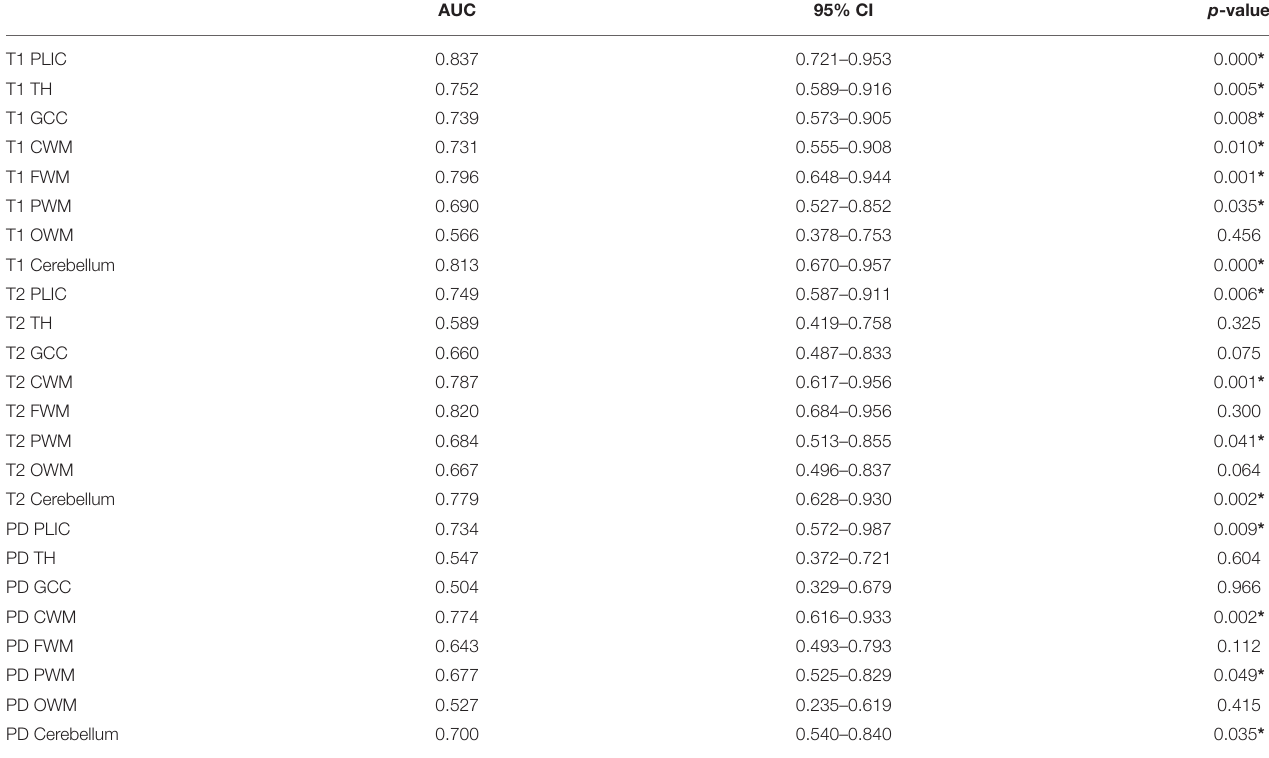
Area under the ROC curve (AUC) analysis to distinguish IVH premature infants from. NON IVH premature infants, based on T1 and T2 relaxation time and PD. CI, Confidence interval. * p < 0.05 is defined as the significance